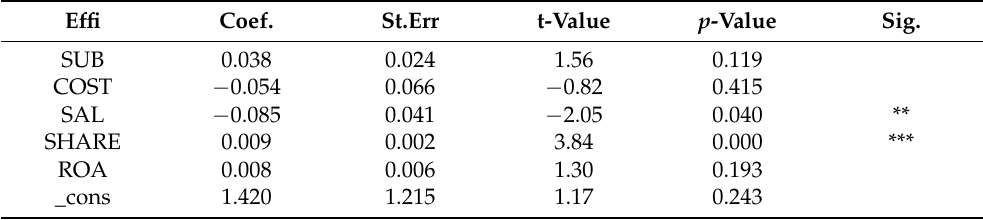
Table 3. Regression